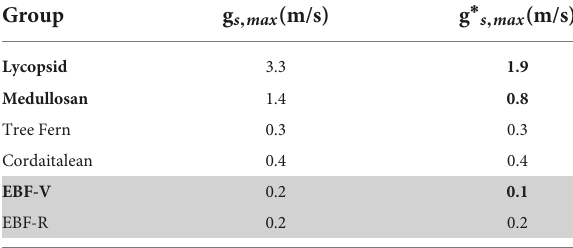
TABLE 2 Fossil informed stomatal conductance